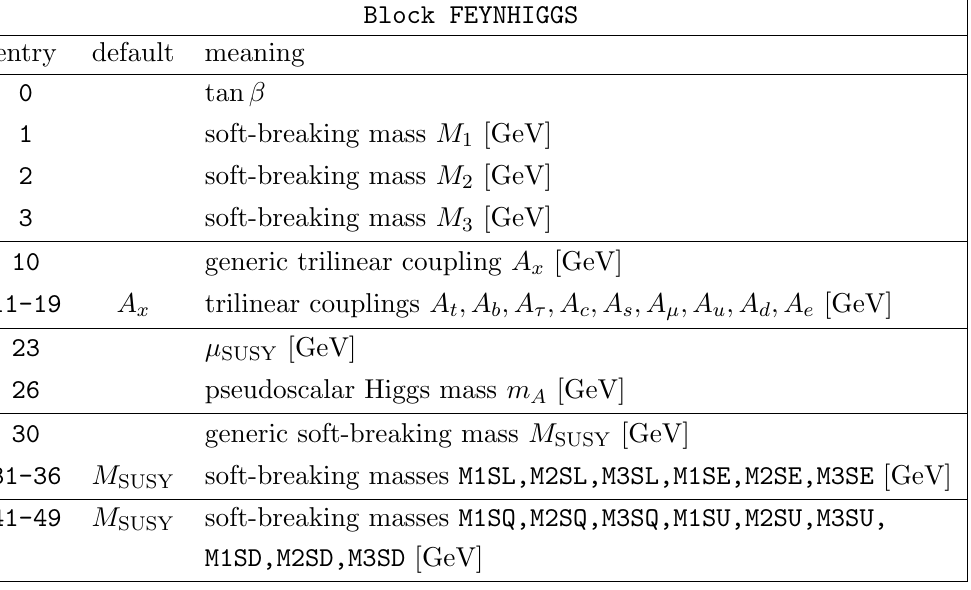
Input parameters of Block FEYNHIGGS . The entries FEYNHIGGS(11-19) and FEYNHIGGS(31-49) are automatically set to the generic values FEYNHIGGS(10) and FEYNHIGGS(30) , if they are not speci(cid:12)ed. The notation of the soft-breaking masses follows the notation of FeynHiggs .